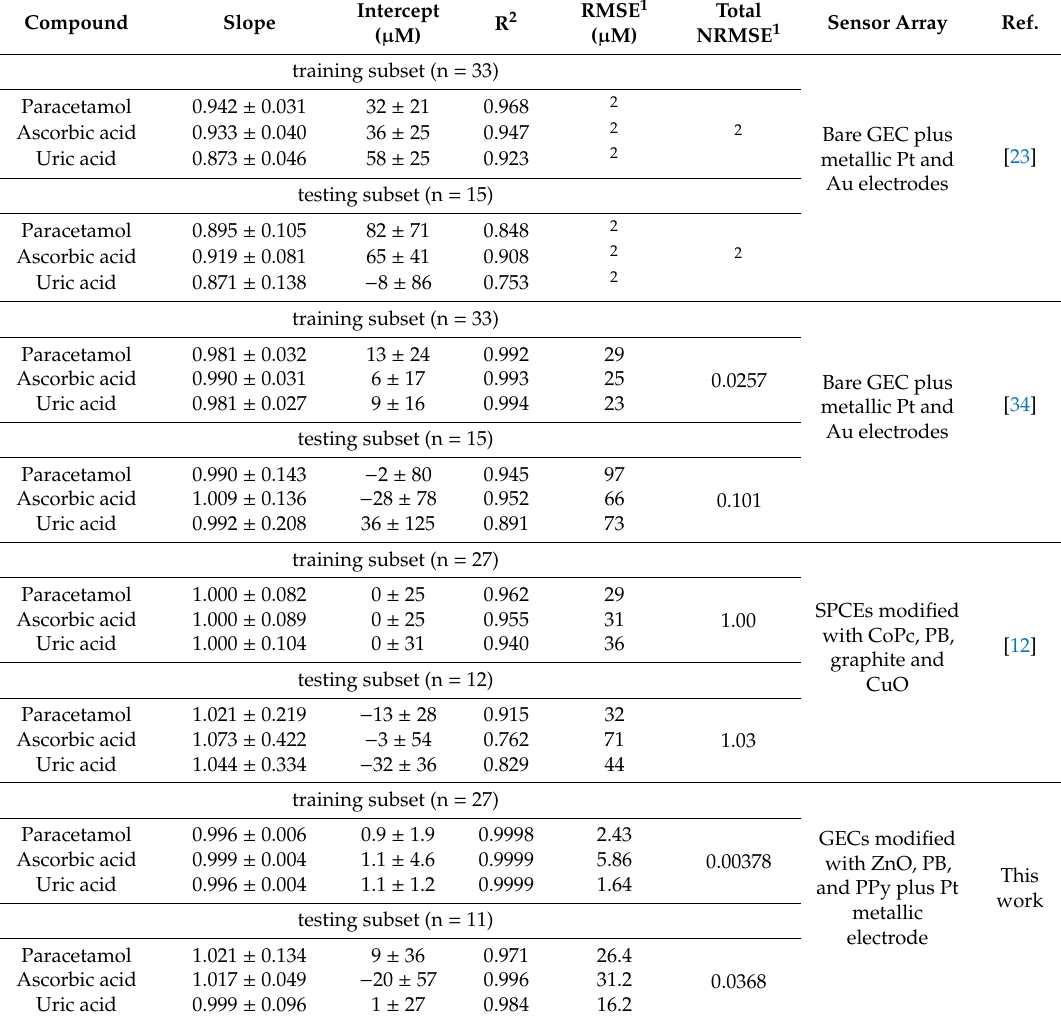
Table 2. Reported values and current results of the fitted regression lines for the comparison between obtained vs. expected values for the di ff erent sets of samples and the three considered APIs. Intervals are calculated at the 95% confidence